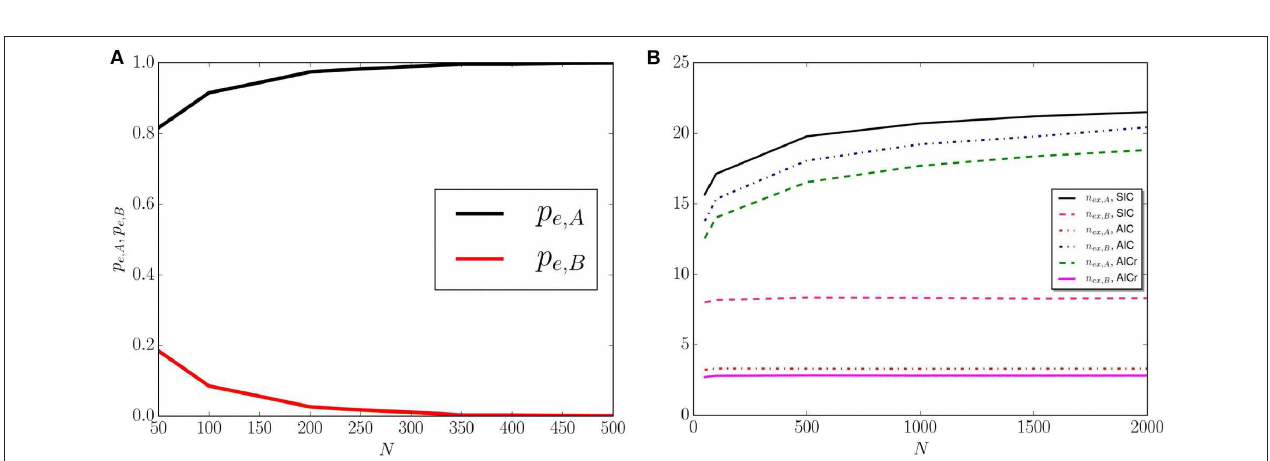
100, the system can converge to consensus both with name A (in a fraction of cases =